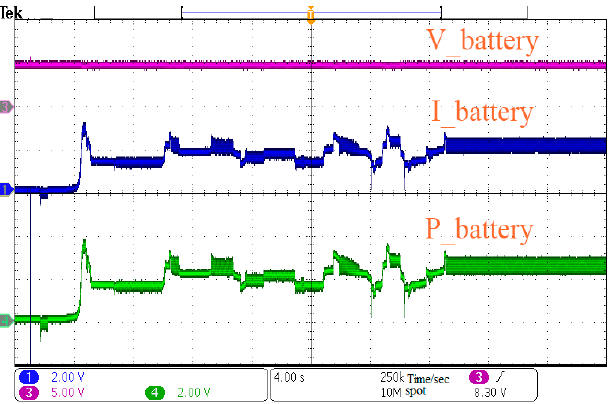
Figure 23. The first PV array’s current, voltage, and power under load constant and radiation changes.